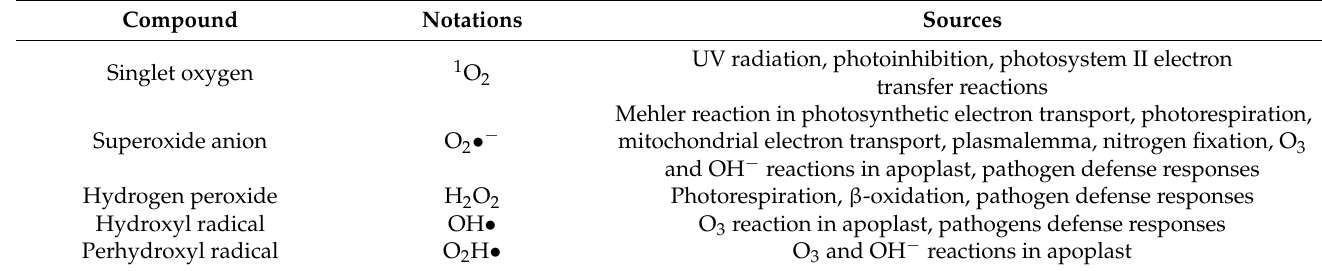
Table 1. Electron donation sources causing ROS